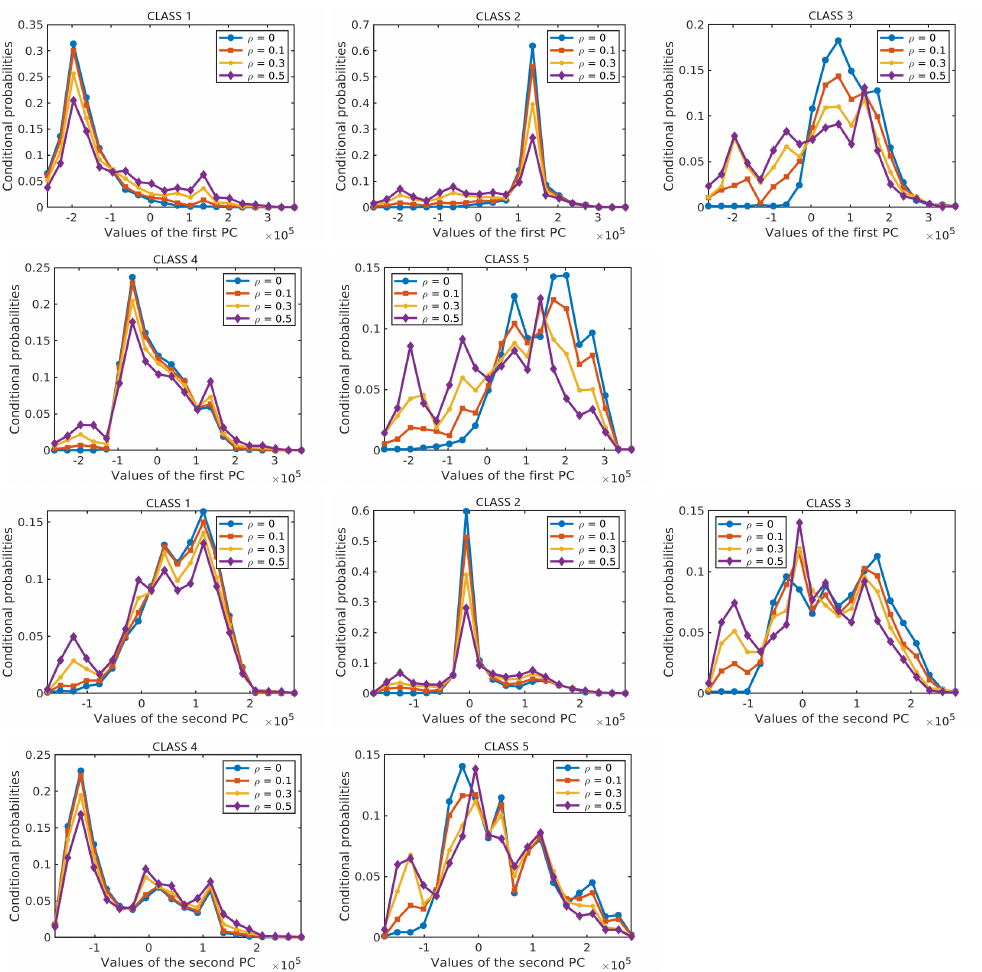
Figure 9. Conditional probabilities of the first PC ( top five diagrams ) and the second PC ( bottom five diagrams ) for different levels of label noise in the HYDICE Urban data